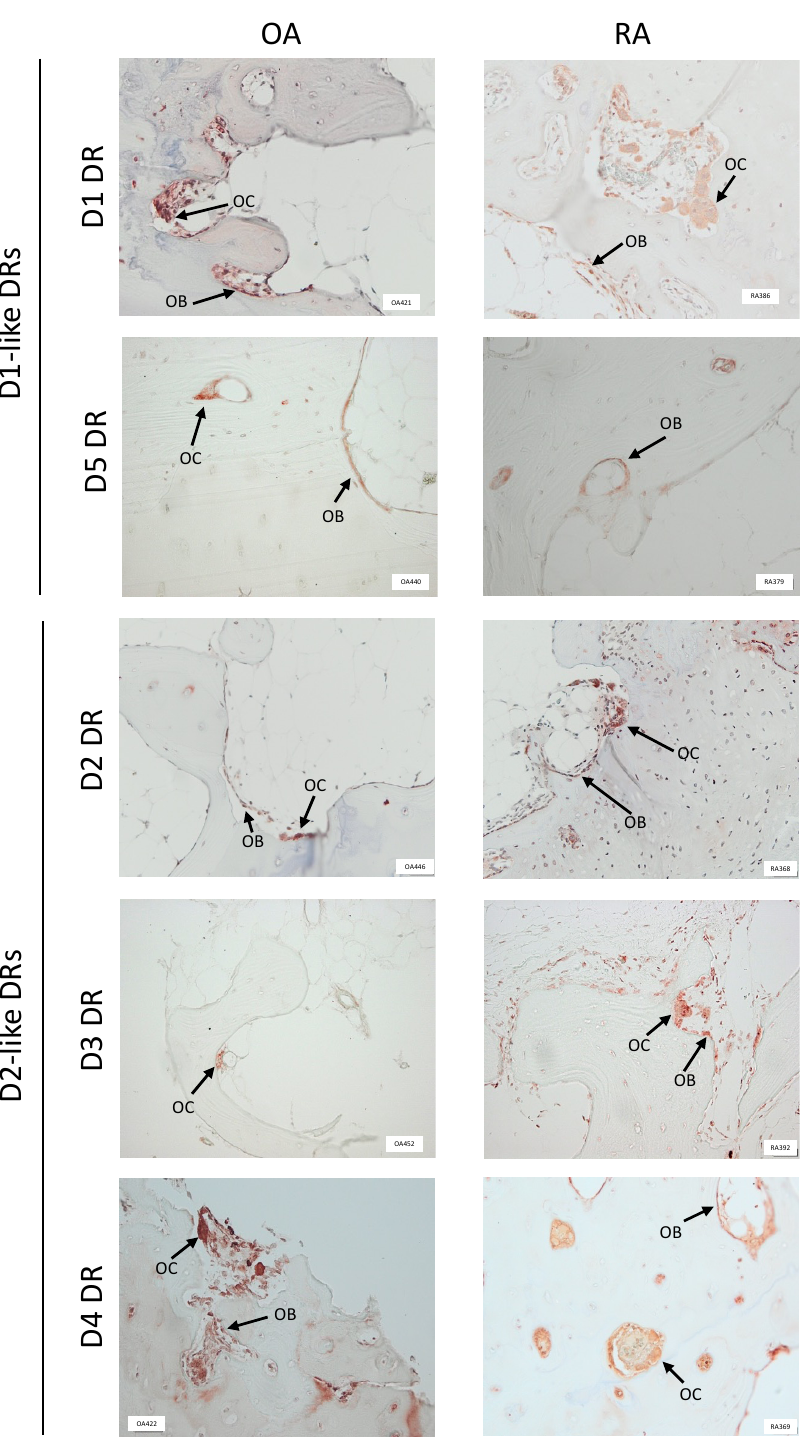
Figure 1. Dopamine receptors are expressed in human bone tissue. Dopamine receptors (DR) were stained in paraffin embedded, decalcified bone samples from at least 10 patients for each group. Representative pictures showing DR positivity at the border of newly formed, non mineralized bone are shown. OB = osteoblasts; OC = osteoclasts. 100× magnification was used in all pictures.